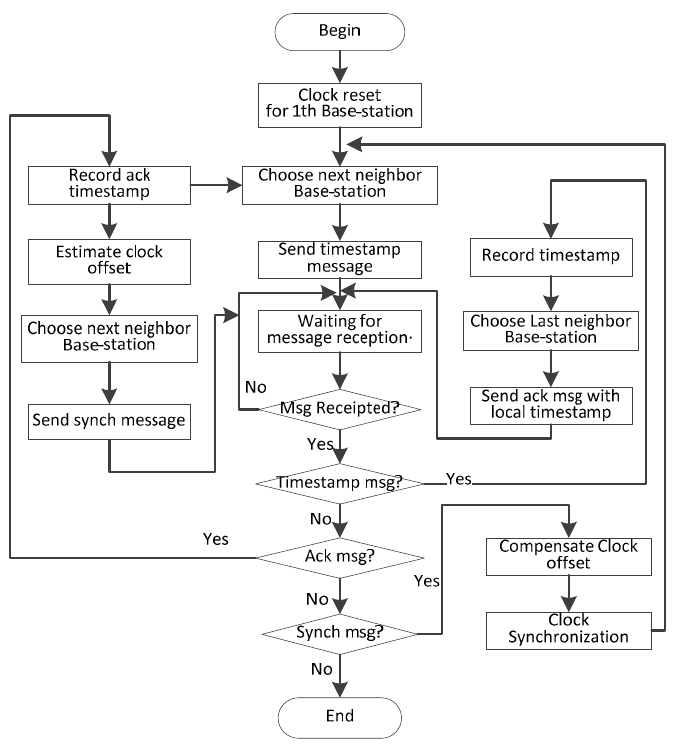
Figure 5. The flow chart of base-station synchronization.